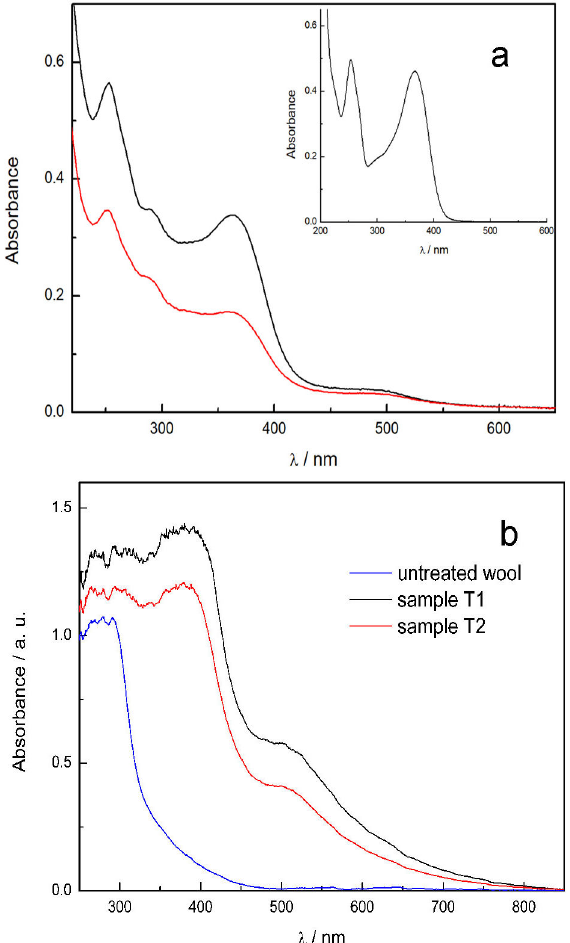
Figure 2. ( a ) Absorption spectrum of onion skin aqueous extract before (black) and after (red) the first dyeing cycle (100-fold diluted with H 2 O). Insert: absorption spectrum of quercetin in water. ( b ) Absorption spectra of untreated wool (UW, blue) and dyed wool in onion skin aqueous extract (T1, black) and its residue